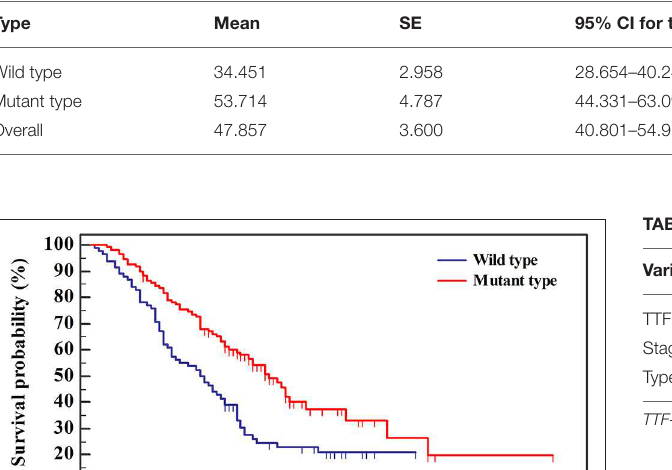
TABLE 4 | Survival analysis for patients with wild-type and mutant patients epidermal growth factor receptor.